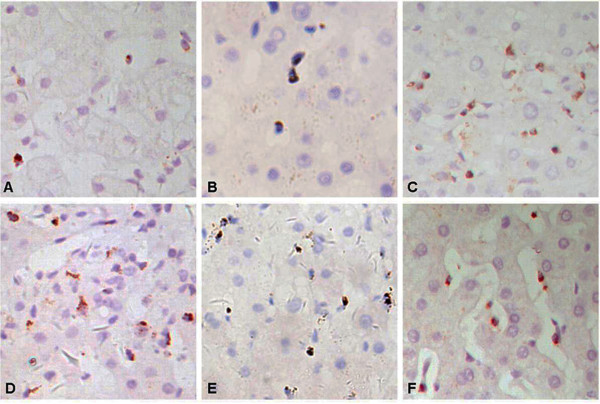
Immunostaining features of perforin, granzyme B and TIA-1 in lobules. The expression of perforin (A) and granzyme B (B) in lobules of biopsies without ACR is sporadic and significantly less than that with ACR (D and E, respectively). However, the expression of TIA-1 in lobules of biopsies without ACR (C) is prevalent, more than that with ACR (F). (Immunostaining with hematoxylin counter staining, ×400).